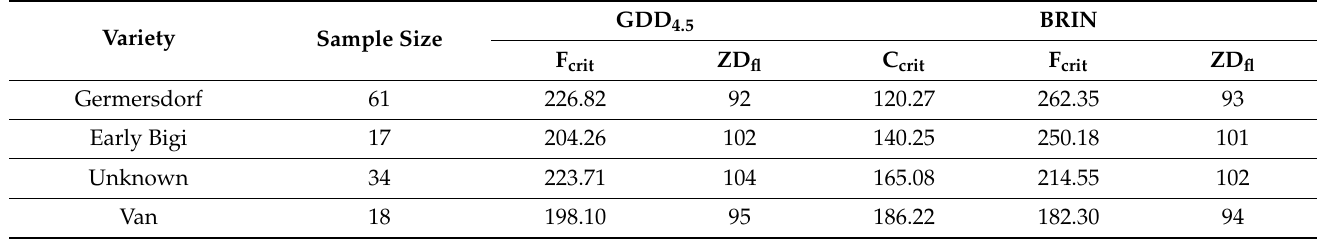
Table A4. Values of calculated parameter sets for several sweet cherry varieties and the two chosen phenological models used in this analysis: GDD and BRIN (both with T b = 4.5 ◦